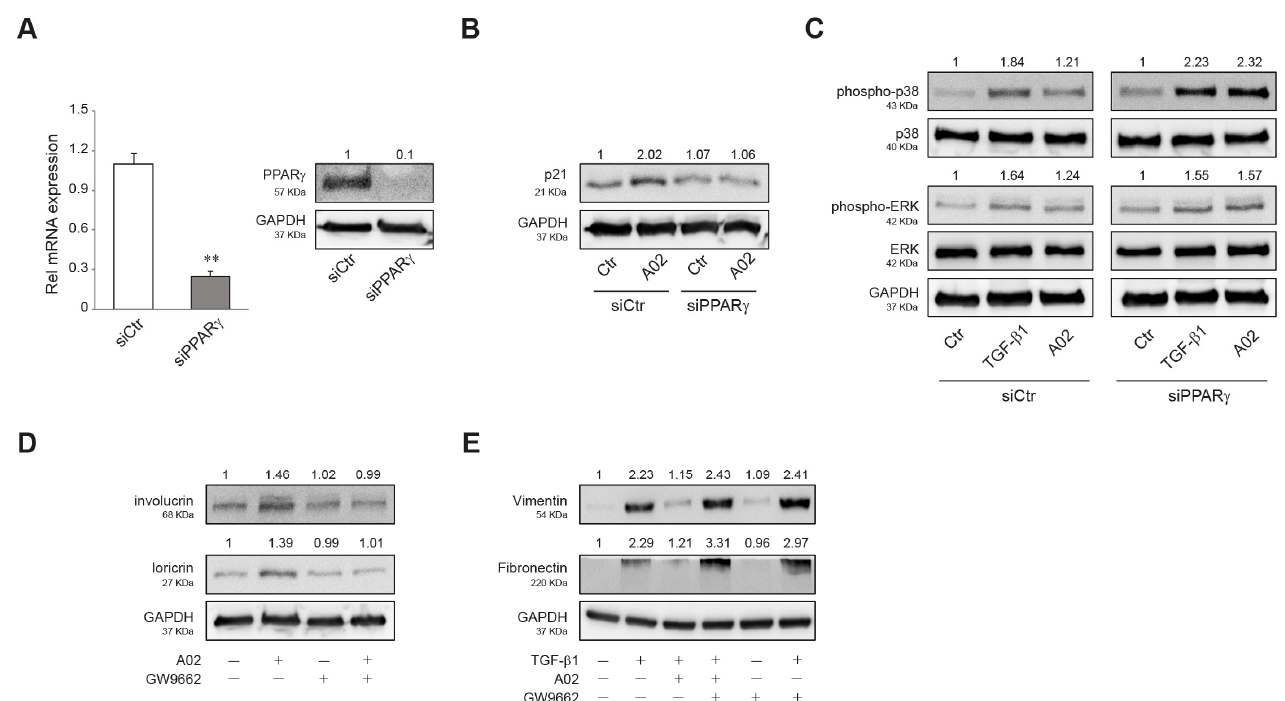
Figure 6. PPAR γ activation is needed to promote A02 biological effects. ( A ) A431 cells were trans- fected with siRNA specific for PPAR γ (siPPAR γ ) or non-specific siRNA (siCtr). PPAR γ level was evaluated by real-time RT-PCR and Western blot analysis 24 h after transfection. The mRNA values were normalized against the expression of GAPDH . The data in the graphs are the mean ± SD of three independent experiments (** p < 0.01 vs. siCtr cells). Representative blots are shown. Western blot analysis of ( B ) p21 and ( C ) phospho-p38, p38, phospho-ERK, and ERK protein expression in A431 cells transfected with siPPAR γ and siCtr exposed to A02 (90 µ M) for 1 h and then treated with TGF- β 1 (15 ng/mL) for 24 h. Representative blots are shown. Western blot analysis of ( D ) involucrin and loricrin and ( E ) vimentin and fibronectin protein expression in A431 pre-incubated with GW9662 (3 µ M) for 1 h, exposed to A02 (90 µ M) for 1 h, and finally treated with TGF- β 1 (15 ng/mL) for 72 h. GAPDH was used as an endogenous loading control for Western blot analysis. Densitometric scanning of band intensities was performed to quantify the change in protein expression. Data represent the mean ± SD of three independent experiments and are expressed as fold change with respect to siCtr cells ( B , C ) and untreated control cells ( D , E ) (control value taken as 1-fold in each case).